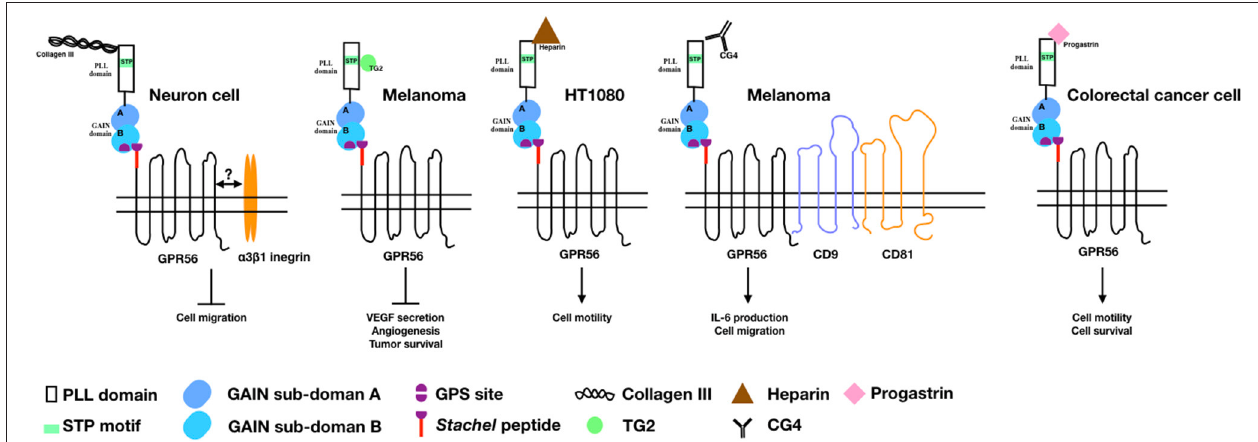
FIGURE 1 | The binding partners/ligands of GPR56 and the cellular functions induced by the GPR56-ligand interaction. Diagrams depict the GPR56 receptor and its various binding partners/ligands as well as the cellular functions resulted from the GPR56-ligand interaction in relevant cell types as indicated.